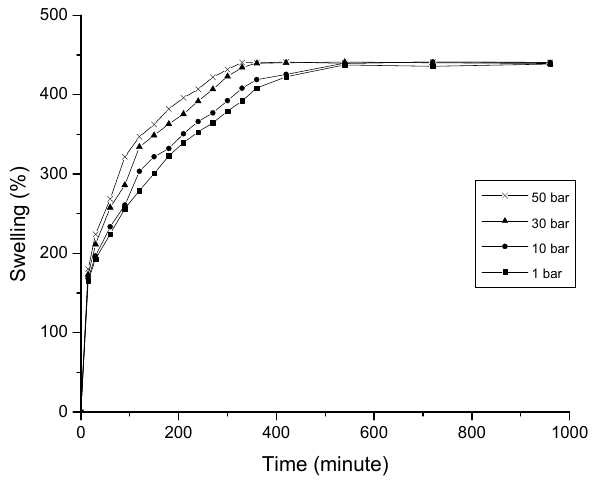
Figure 5. Equilibrium swelling ratio of hydrogels formed at different pressure conditions.